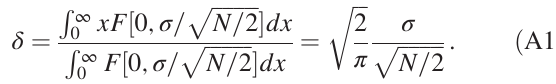
Fig. 14 are close to, but not equal to, the spin coherence times from their respective data sets.